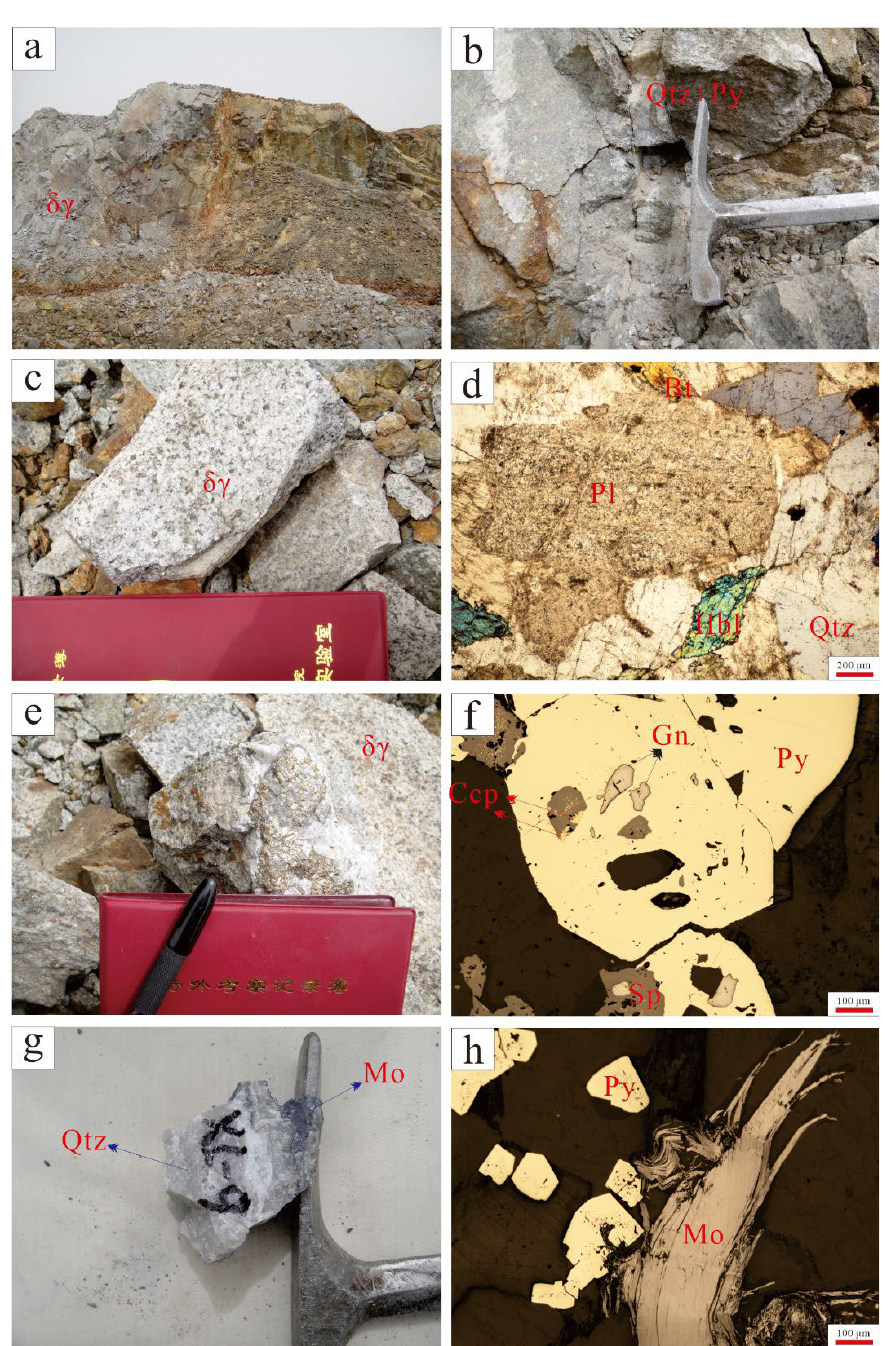
Figure 4. Macro- and micro-photographs of Mo mineralization within the granodiorite from Xianlin Mo(Cu)-Fe deposit: ( a ) open pit; ( b ) the quartz + pyrite + minor molybdenite vein; ( c ) mineralized granodiorite; ( d ) photomicrograph of mineralized granodiorite in the cross-polarized light; ( e ) granodiorite with disseminated pyrite; ( f ) microphotograph of ore, showing early pyrite partially replaced by late-stage galena, sphalerite, and chalcopyrite; ( g ) fragment of quartz-molybdenite vein; ( h ) pyrite and molydenite. δγ –Granodiorite; Pl–Plagioclase; Bt–Biotite; Hbl–Hornblende; Qtz–Quartz; Mo–Molybdenite; Py–Pyrite; Gn–Galena; Sp–Sphalerite; Ccp–Chalcopyrite.